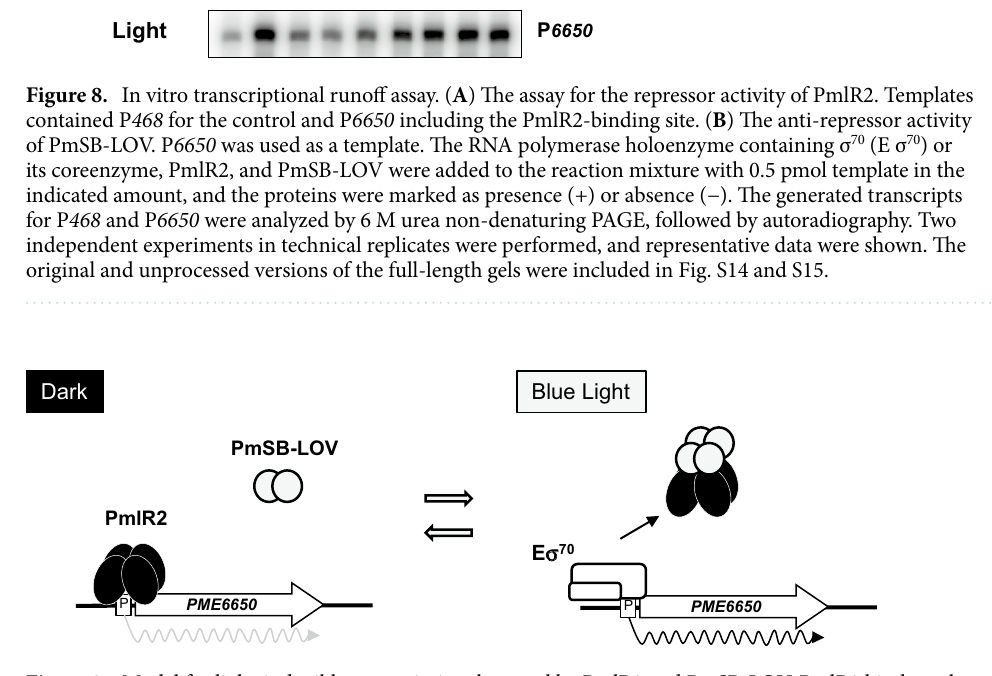
Figure 9. Model for light-inducible transcriptional control by PmlR2 and PmSB-LOV. PmlR2 binds to the promoter region of the light-inducible P 6650 and prevents transcriptional initiation by RNA polymerase holoenzyme containing σ 70 . Upon illumination, PmSB-LOV becomes active and forms a covalent thiol-adduct with FMN. Activated PmSB-LOV associates with PmlR2, abolishing its DNA-binding activity and allowing RNA polymerase to initiate transcription from P 6650 . Dark incubation causes the covalent FMN-C4a-cysteinyl- thiol adduct to break, leading to dissociation of PmlR2 and PmSB-LOV and inhibition of P 6650 by the binding of